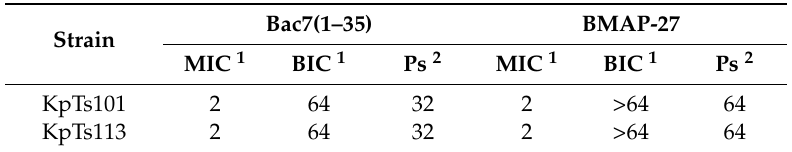
(Ps column) together with MIC and BIC values from Table 1 for an easy comparison. The results do indicate that polysaccharides significantly contribute to the protective action of the matrix. To